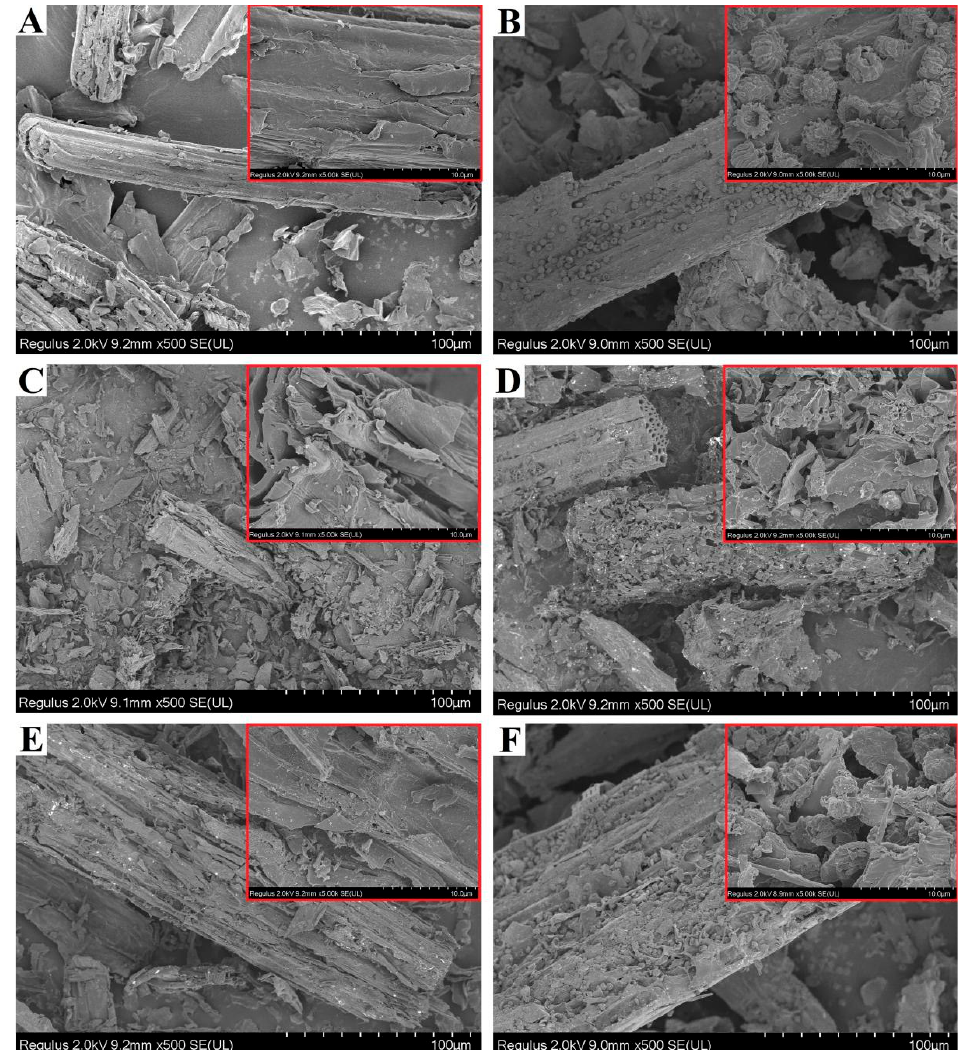
Figure 1. SEM of ( A ) ITG, ( B ) MITG, ( C ) CITG, ( D ) CMITG, ( E ) ITGB, and ( F ) MITGB. The influence of temperature on ITG and MITG was obtained by TGA tests under The functional groups of the sample were analyzed by FT-IR spectra test as shown nitrogen protection as shown in Figure 2A. The TGA curves correspond to the different in Figure 2B. The broad bond at 3384–3436 cm − 1 represents stretching vibrations of hy- stages of biochars formation, which indicates that there are three main stages of weight droxyl functional groups (O-H). The bond at 2919–2928 cm − 1 represents symmetrical and loss in the range from room temperature to 1200 °C. The first stage occurred at room tem- asymmetrical stretching vibrations of -CH, -CH 2 , and -CH 3 groups [22–28]. The bond at perature to 200 °C, which was caused by evaporation and loss of residual water from 1729–1731 cm − 1 represents the stretching vibration of C=O. The bond at 1601–1635 cm − 1 physical surfaces and internal pores [22,23]. Like many other biomasses, the main oxygen- represents the axial deformation of the carbonyl group (C=O). The bond at 1374–1375 cm − 1 ated components of ITG and MITG are cellulose, hemicellulose, lignin, protein, and fat, represents the C-H symmetric bending vibration of the methyl group [14,22]. The bonds at which could be broken into gas and tar during the high-temperature pyrolysis process 1251–1252 cm − 1 and 1419–1421 cm − 1 represent the deformation vibration of methylene. [22–24]. The removal of these pyrolytic materials results in the weight loss of the second The bonds around 1047–1159 cm − 1 represent the tensile vibrations of C-O from alcohols, stage. As for the third stage (from 600 to 1200 °C), especially when temperatures exceed phenols, acids, or esters [23,24]. Interestingly, the new bond at 1517 cm − 1 from MITG 800 °C, the weight loss was mainly due to the cleavage of some minerals [31,32]. Com- represents the stretching vibration of a mononuclear aromatic hydrocarbon [33]. It can pared with ITG, the pyrolysis behavior of MITG was more obvious, which indicated that be inferred that the degradation of macromolecular organic materials does occur after the mineral composition of MITG was higher than that of ITG. It can be speculated that the microbial treatment by A. niger , and thus the stretching vibration of the mononuclear there were two reasons, on the one hand, the residual A. niger spores after microbiological aromatic hydrocarbon and olefin occurs treatment, and on the other hand, the residue of inorganic salt culture medium added in the process of microbial treatment. In order to obtain carbonized samples more stably, the